Question: Compose a caption that would accompany this figure in a paper.
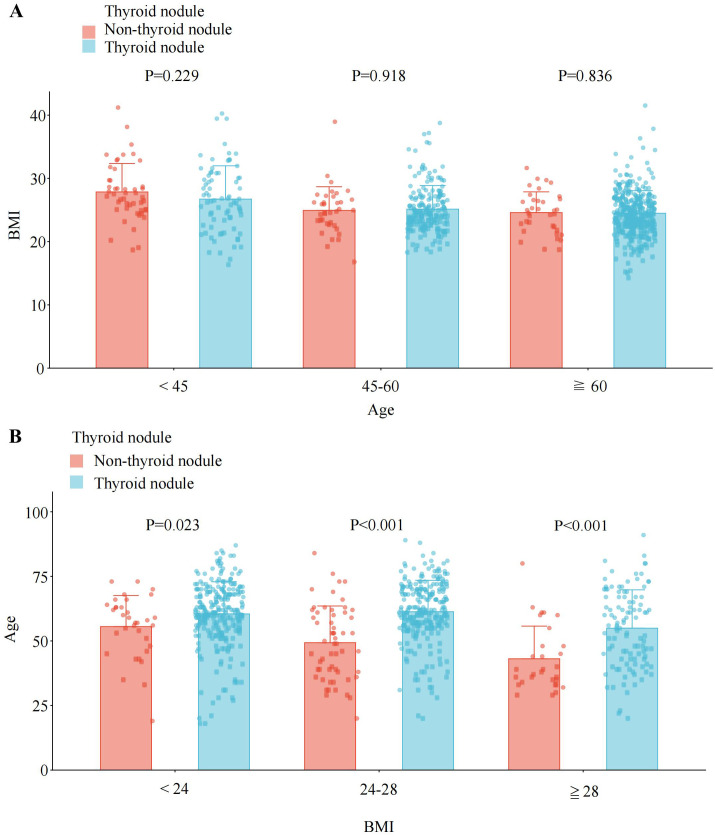
Answer: Distribution of age and BMI between the thyroid nodule group and non-thyroid nodule group, and comparison between groups. (A) Participants were divided into subgroups based on age grouping. (B) Participants were divided into subgroups based on BMI grouping.